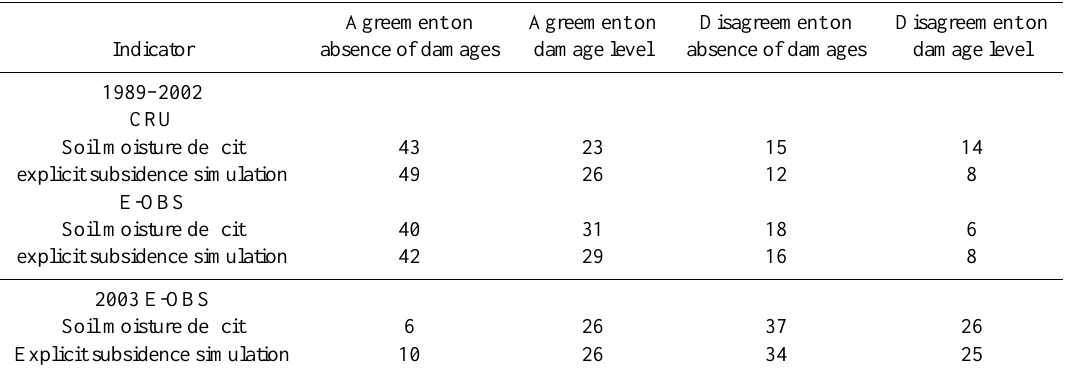
Table 1. Evaluation of simulated damage costs on departmental level. Number of departments with agreement or disagreement between simulated and observed damage costs concerning the absence of substantial damage levels or on the damage level within the range of uncertainty. See text for exemplary